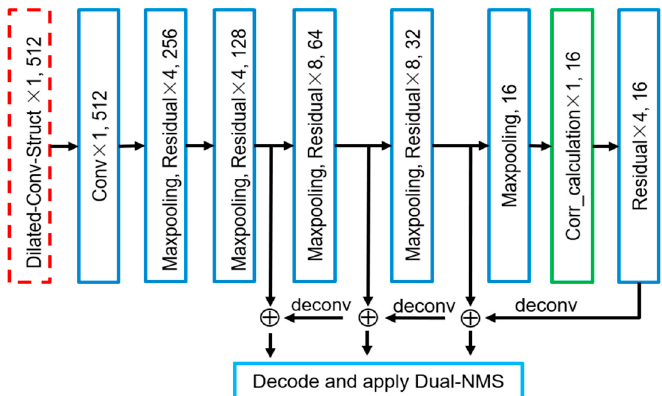
Figure 4. CorrNet structure. The red dashed box indicates the dilated convolution guidance structure. The green box represents the correlation calculation layer of the feature channel separation. The downsampling rates of the feature map of the original YOLOv3 for decoding the calculation loss is 8, 16 and 32, which makes it easy to cause small object losses.